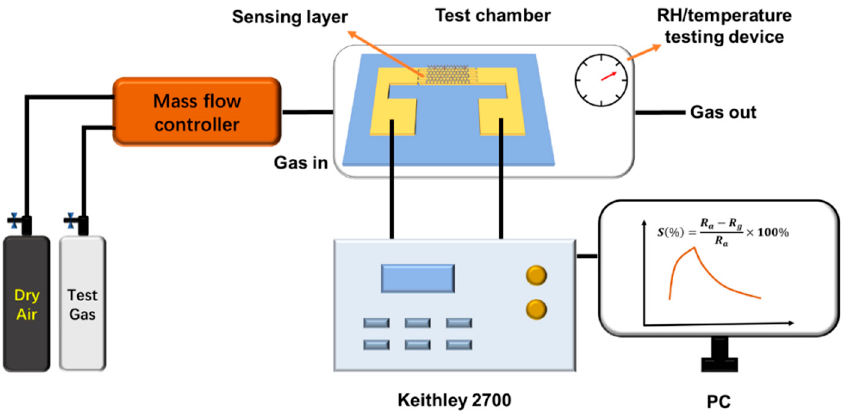
Figure 2. Diagram of the gas-sensing testing system.